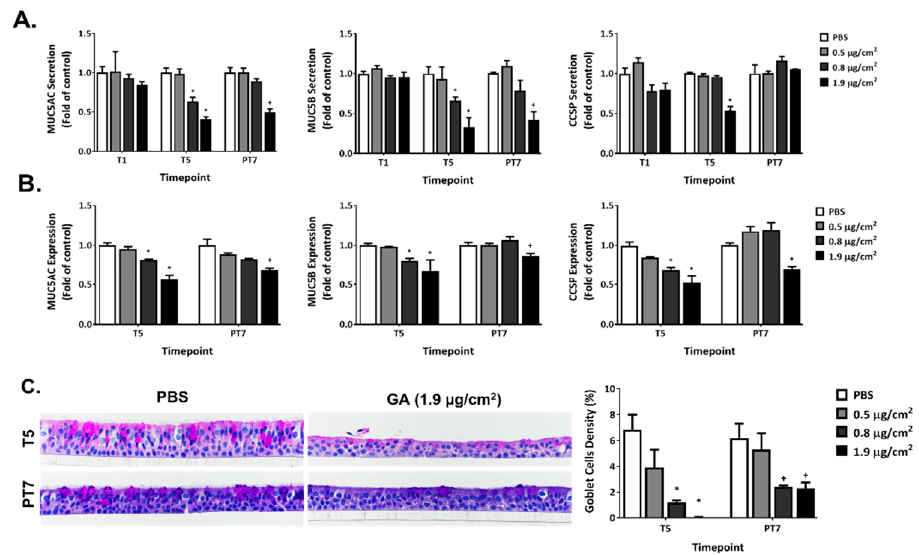
Figure 6. Modulation of GA aerosols on mucin homeostasis. Secretion ( A ) and expression ( B ) of MUC5AC, MUC5B, and CCSP were measured at T1 (only for mucin secretion), T5 and PT7. ( C ) Morphology and density of goblet cells were assessed at T5 and PT7 using periodic acid-Schiff (PAS) staining. Images were captured at 40× and presented in the middle panel. The percentage of goblet cells was calculated as described in the Materials and Methods section and is presented in the lower panel. Data (n = 3) are expressed as means ± SEM. * ,+ p < 0.05 was considered statistically significant compared to the respective vehicle controls.